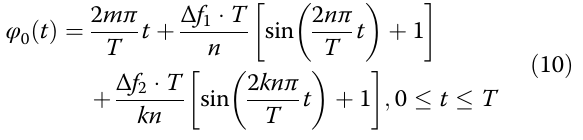
in which T is the modulation period, and n and p are integers. The instantaneous frequency is f 0 ð t Þ ¼ f c þ ð m T n Þ þ pt n . We remark that the linear (cid:4) p T n þ 1 FMCW is a special case with n = 1. Figure 3a and b t ð Þ and the baseband demonstrate the required phases φ 0 waveforms of the quadratic ( n = 2, m = 5, and p = 15 ) and T 3 cubic ( n = 3, m = 5, and p = 20 ) polynomial FMCWs. T 4